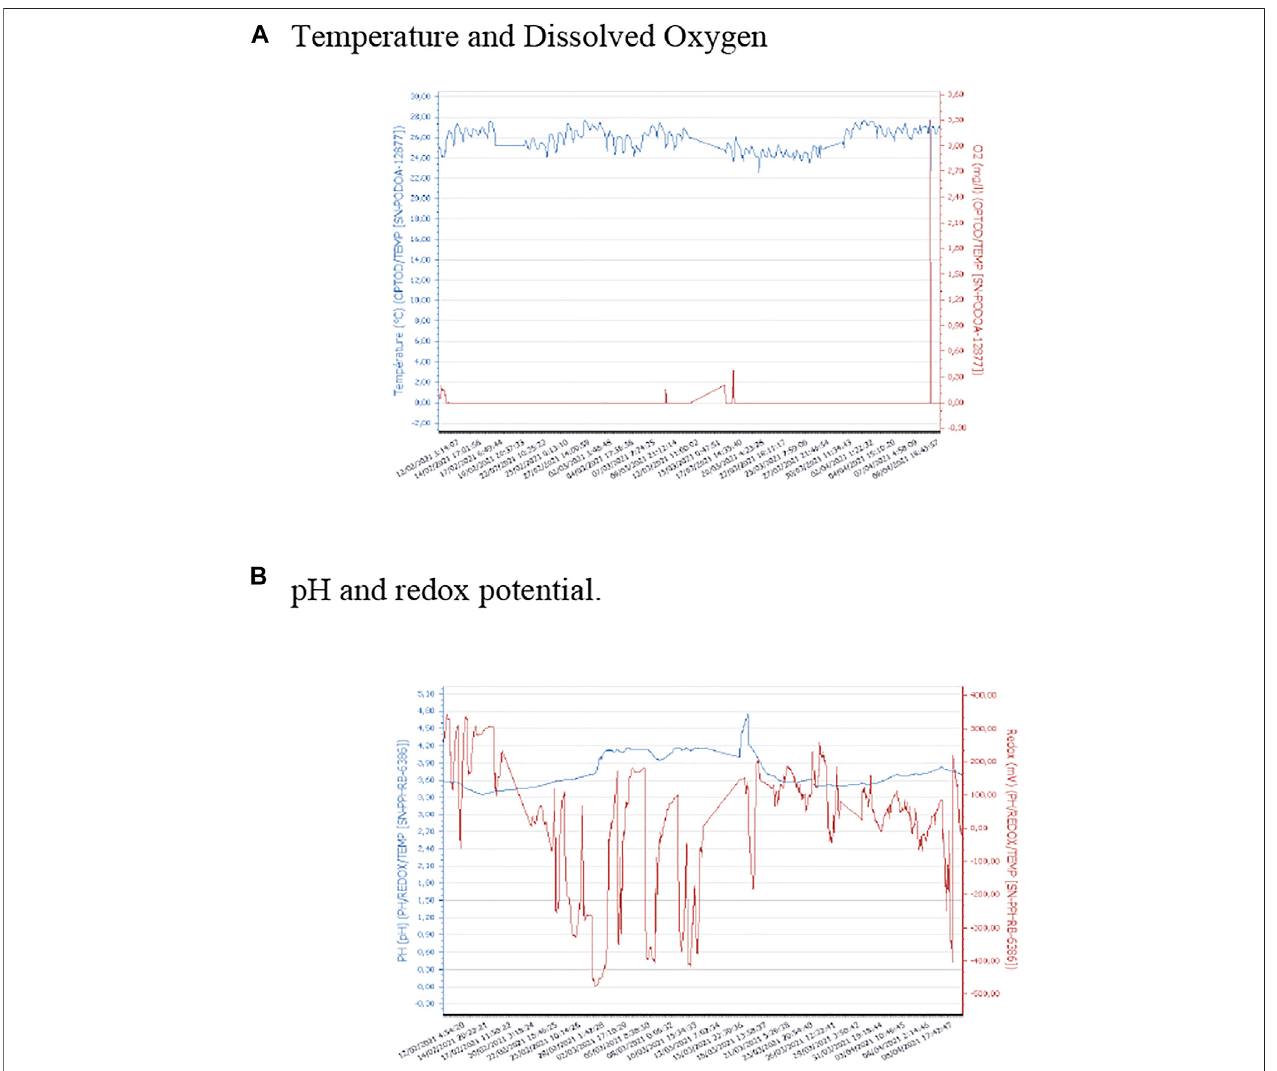
FIGURE 3 | Monitoring of physicochemical parameters during operation of MFC1. (A) Temperature and Dissolved Oxygen. (B) pH and redox potential.